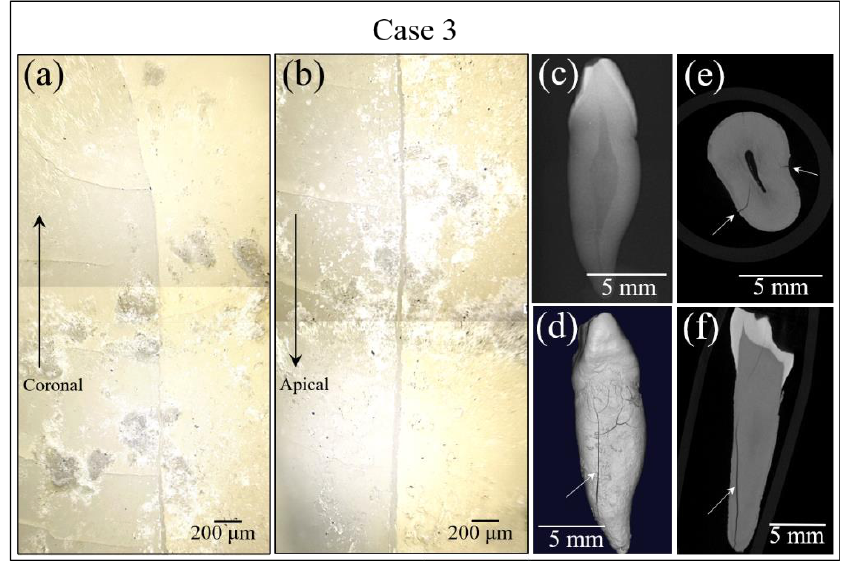
Figure 5. ( a – c ) Results of conventional X-ray analyses in the tooth sample of Case 2. ( d – g ) High-resolution micro-CT scanning examinations of the same sample. Dotted circles indicate cavities.